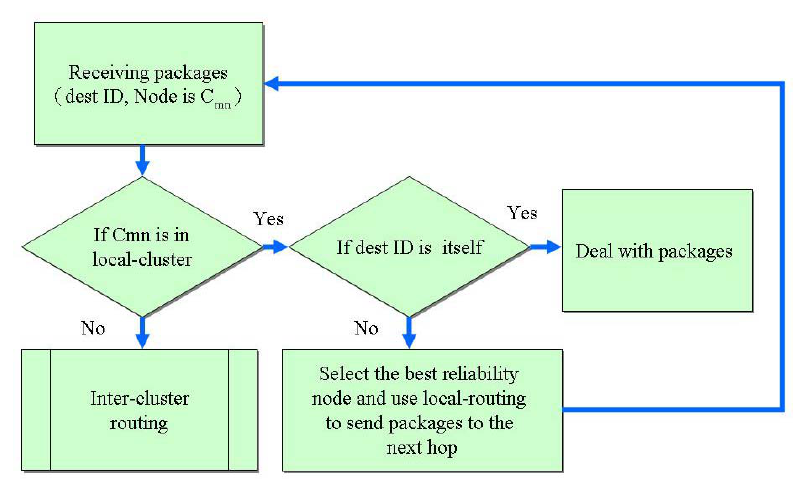
Figure 7. Intra-cluster routing